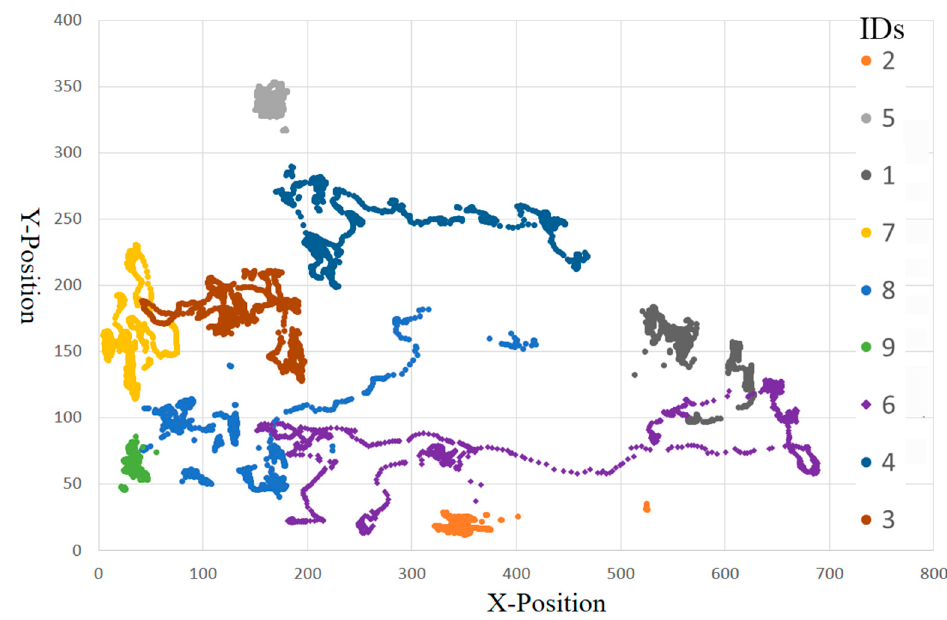
Figure 10. The predicted trajectories of nine pigs using our method. Table 3. Evaluation results of our method for individual pigs’ detections and